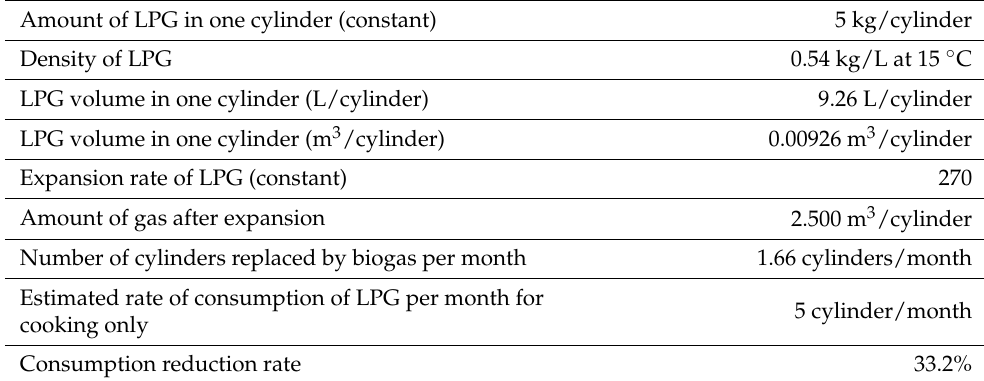
Table 9. Calculation on the LPG replacement for cooking purposes. Amount of LPG in one cylinder